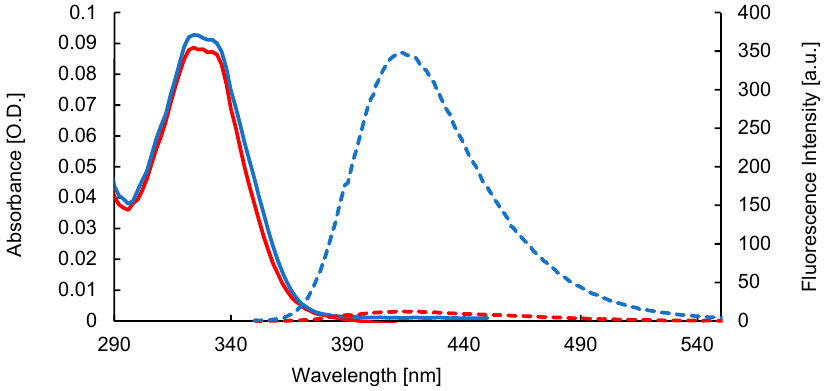
Figure 2. Absorption and fluorescence emission spectra of FN 14 (absorbance ( — ), fluorescence ( - - )); FM 17 (absorbance ( — ), fluorescence ( - - )). Measured in H 2 O, λ ex = 340 nm and 9 µM for both FN 14 and FM 17 .